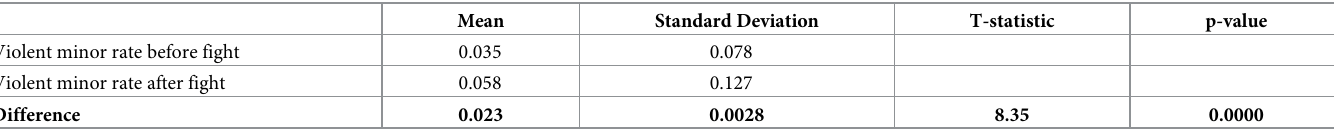
Table 4. Difference in violent minor rate before and after